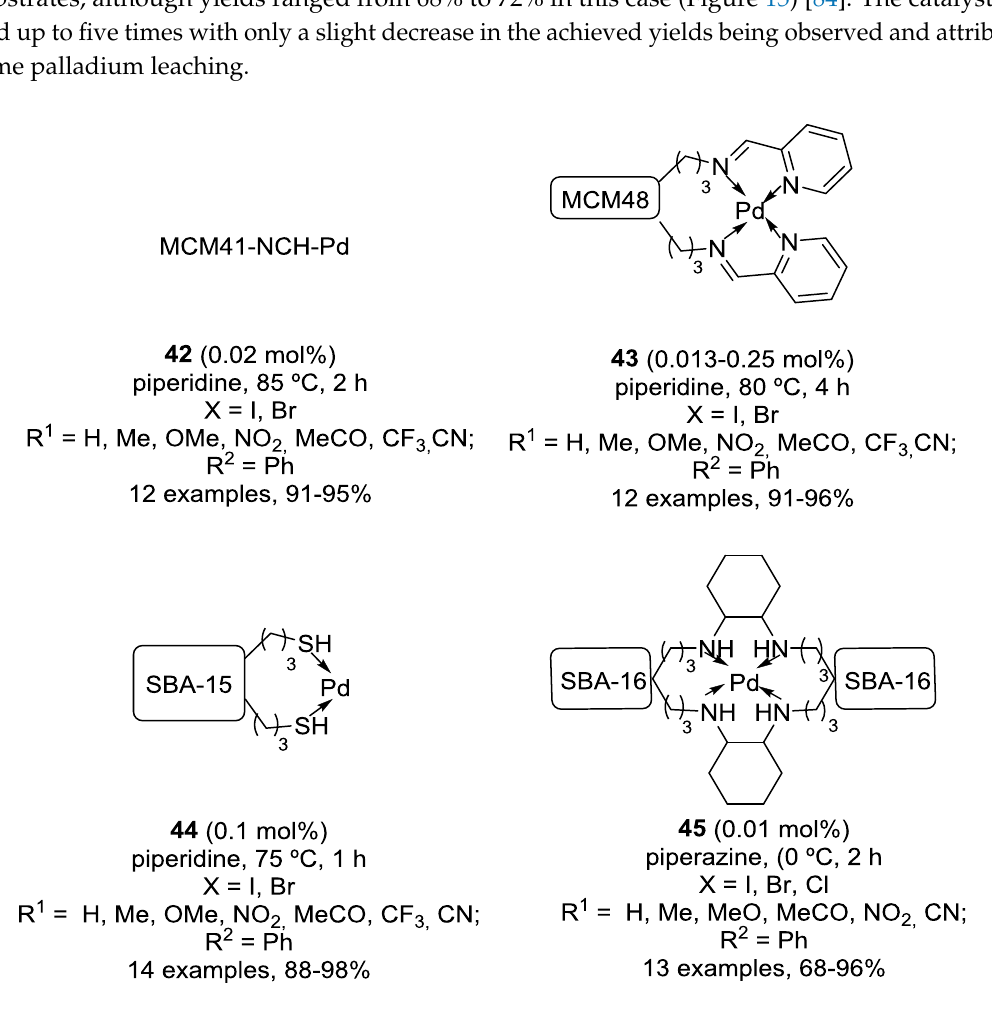
Figure 15. Mesoporous silica-supported palladium catalyst used in the Sonogashira cross-coupling reaction. Conditions, substrate scope and yield range (Scheme 2).